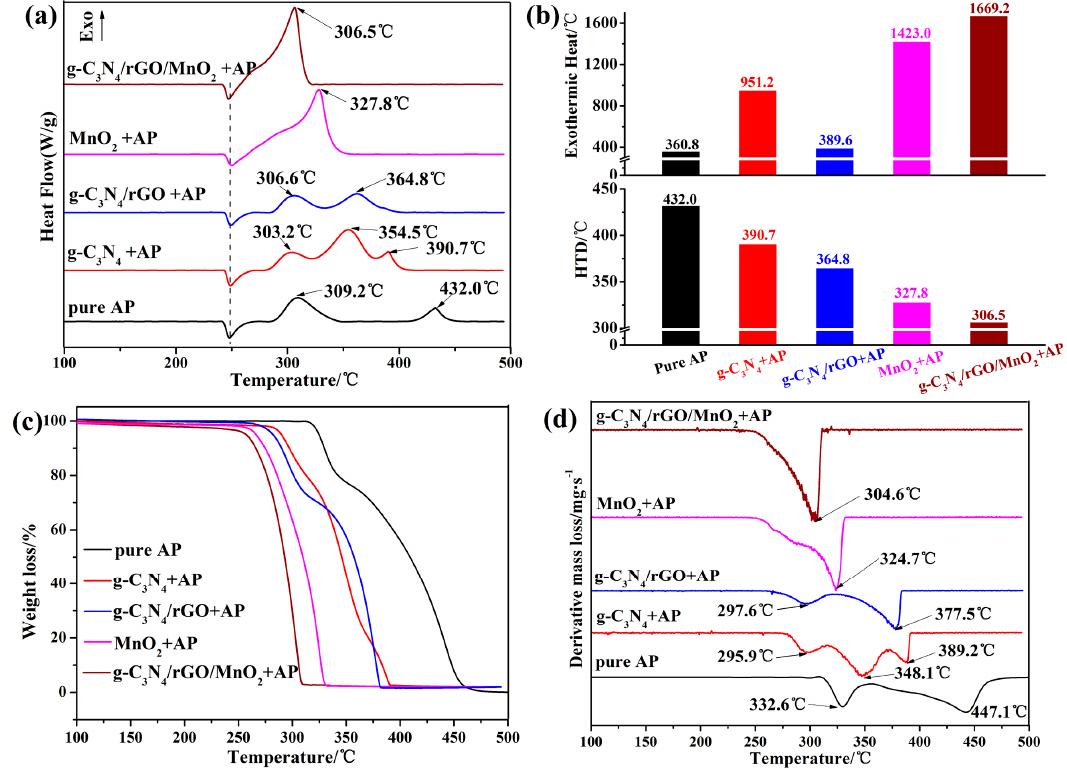
Figure 7. ( a ) DSC curves of AP in the absence and presence of catalysts. ( b ) histogram of the corresponding high decomposition temperature (HTD) and exothermic heat in Figure 7a. ( c ) TG and ( d ) DTG curves of AP in the absence and presence of catalysts. (the mass radio of catalyst to AP is 1:49).